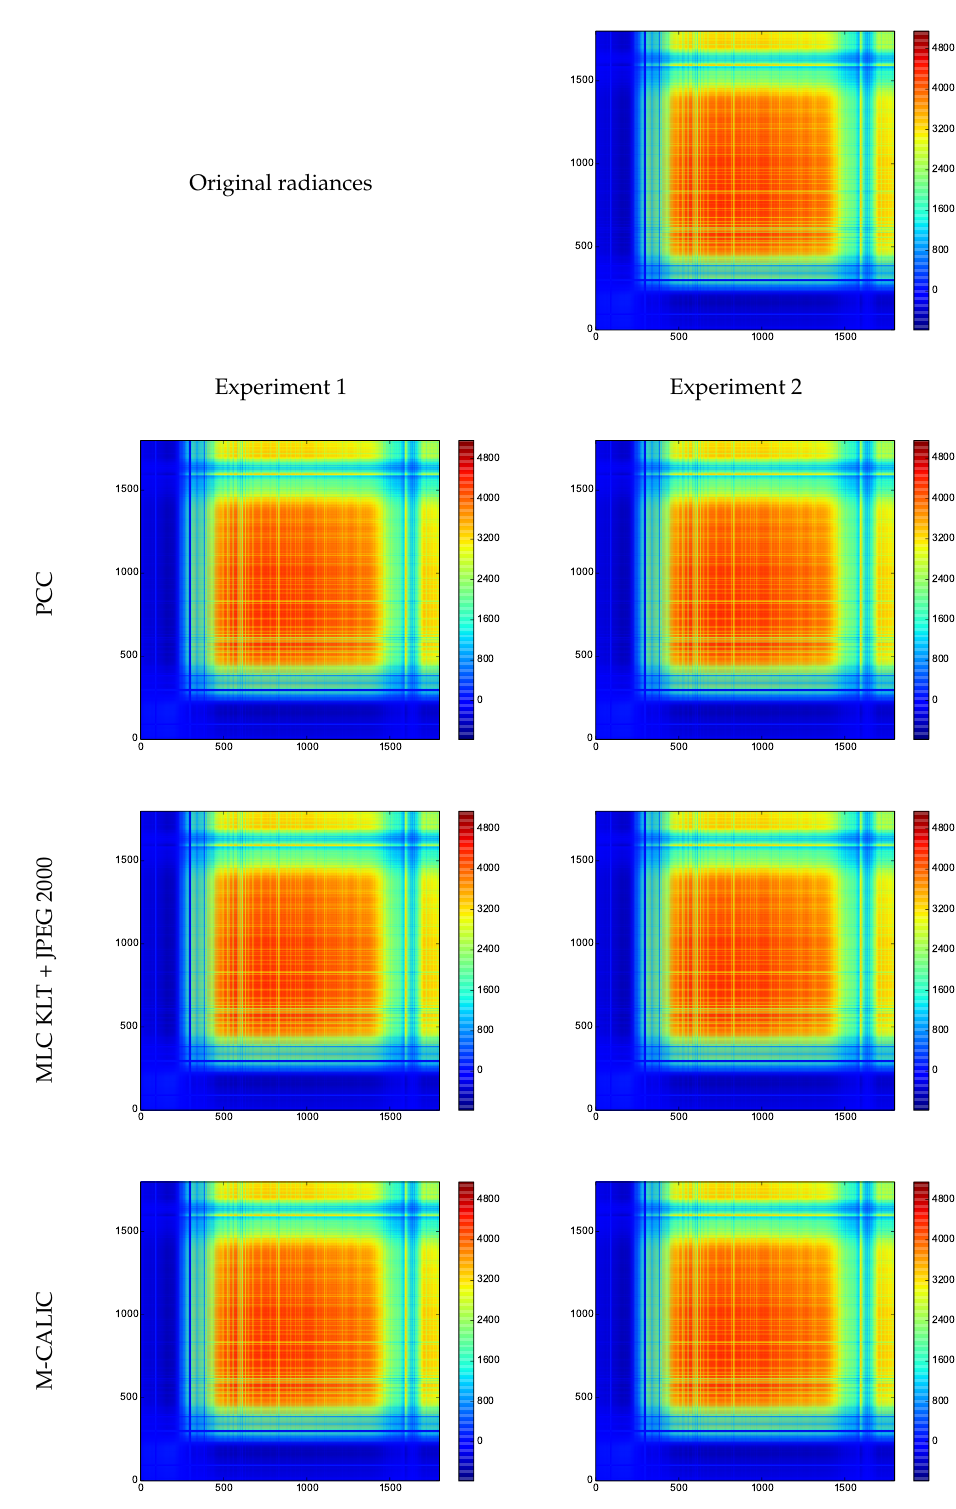
Figure 16. Covariance matrix of the original radiances and covariance matrix of the reconstructed